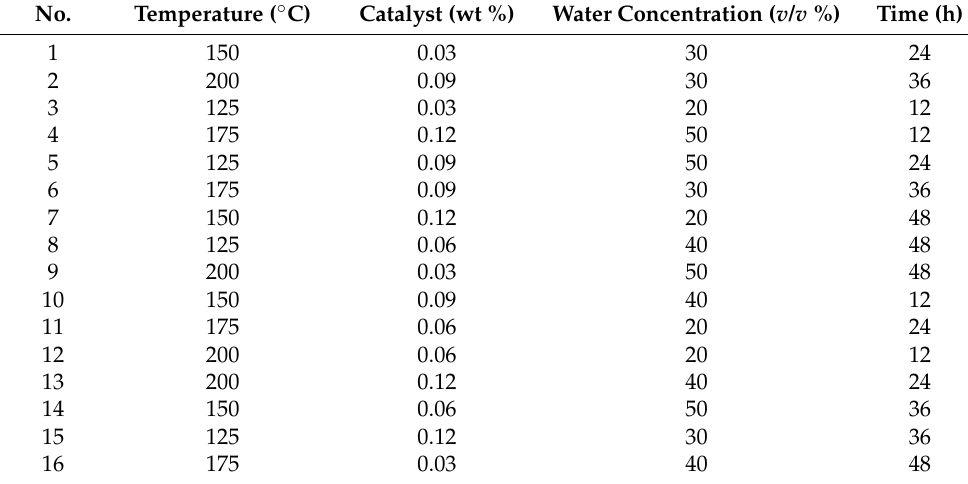
Table 3. Orthogonal design of